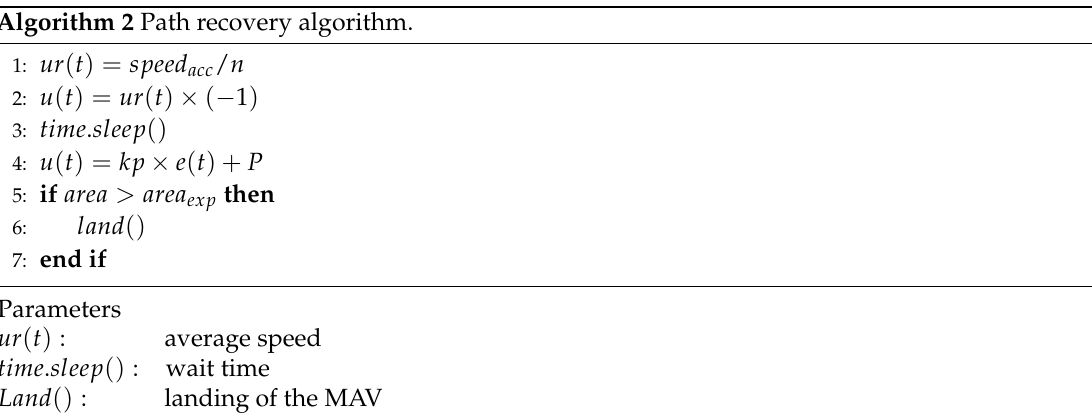
Algorithm 2 Path recovery